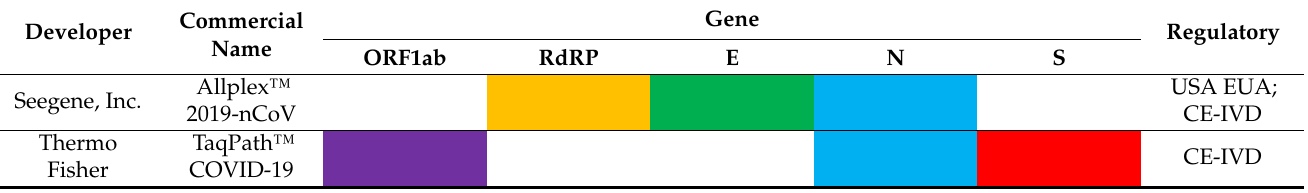
Table 1. Gene target points similarity.